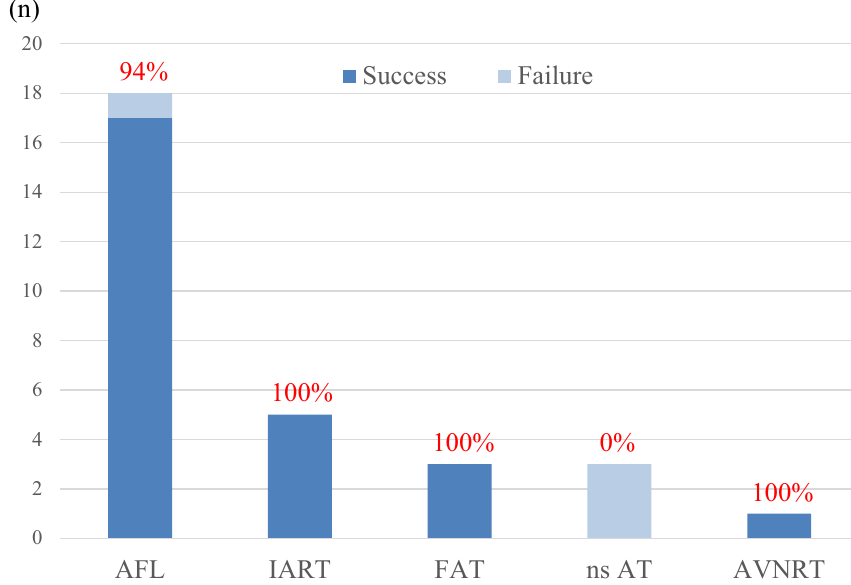
Figure 2. Changes before and after the first RFCA procedure. ( A ) Number of AADs administered 1 month before and after the first RFCA. ( B ) Serum BNP levels 1 month before and after the first RFCA. ( C ) Number of hospitalizations due to heart failure or arrhythmia during 1 year before and after the first RFCA. AAD: antiarrhythmic drug, BNP: brain natriuretic peptide, RFCA: radiofrequency catheter